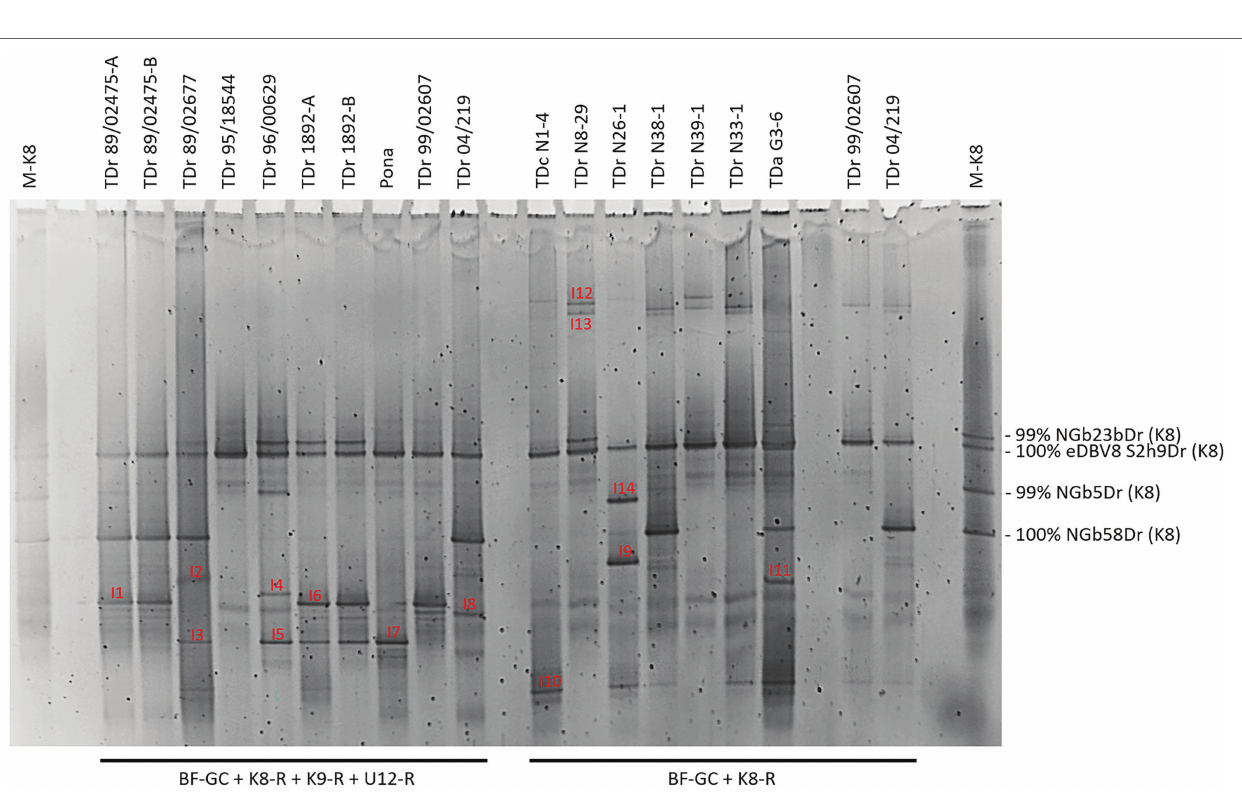
FIGURE 2 | Comparison of multiplex PCR-DGGE (left-hand side) to group K8 single plex PCR-DGGE analysis (right-hand side) of partial RT-RNaseH badnavirus sequences. Samples shows are from one landrace (Pona), nine breeding lines of D. rotundata (TDr) and seven yam field samples from Nigeria and Ghana (TDr or TDa with sample number prefixed with N or G to denote country. Multiplex PCR amplifications were done using primers BF-GC, K8-R, K9-R and U12-R and single plex PCR with primers BF-GC and K8-R. D. rotundata accession TDr 89/02475-A and -B and TDr 1892-A and -B are clones of the same yam accessions. D. rotundata breeding lines TDr 99/02607 and TDr 04/219 were included for comparison. Fourteen distinct bands (I1–I14) were excised, re-amplified, cloned and sequenced. Typically, two clones per excised DGGE band were sequenced, and both sequences are presented in Table 1 except for those which were found to be 100% identical to each other. M-K8 denotes DGGE sequence marker (see section “Development of DGGE Marker for Quick Identification of Common Endogenous Badnavirus Sequences in Yam